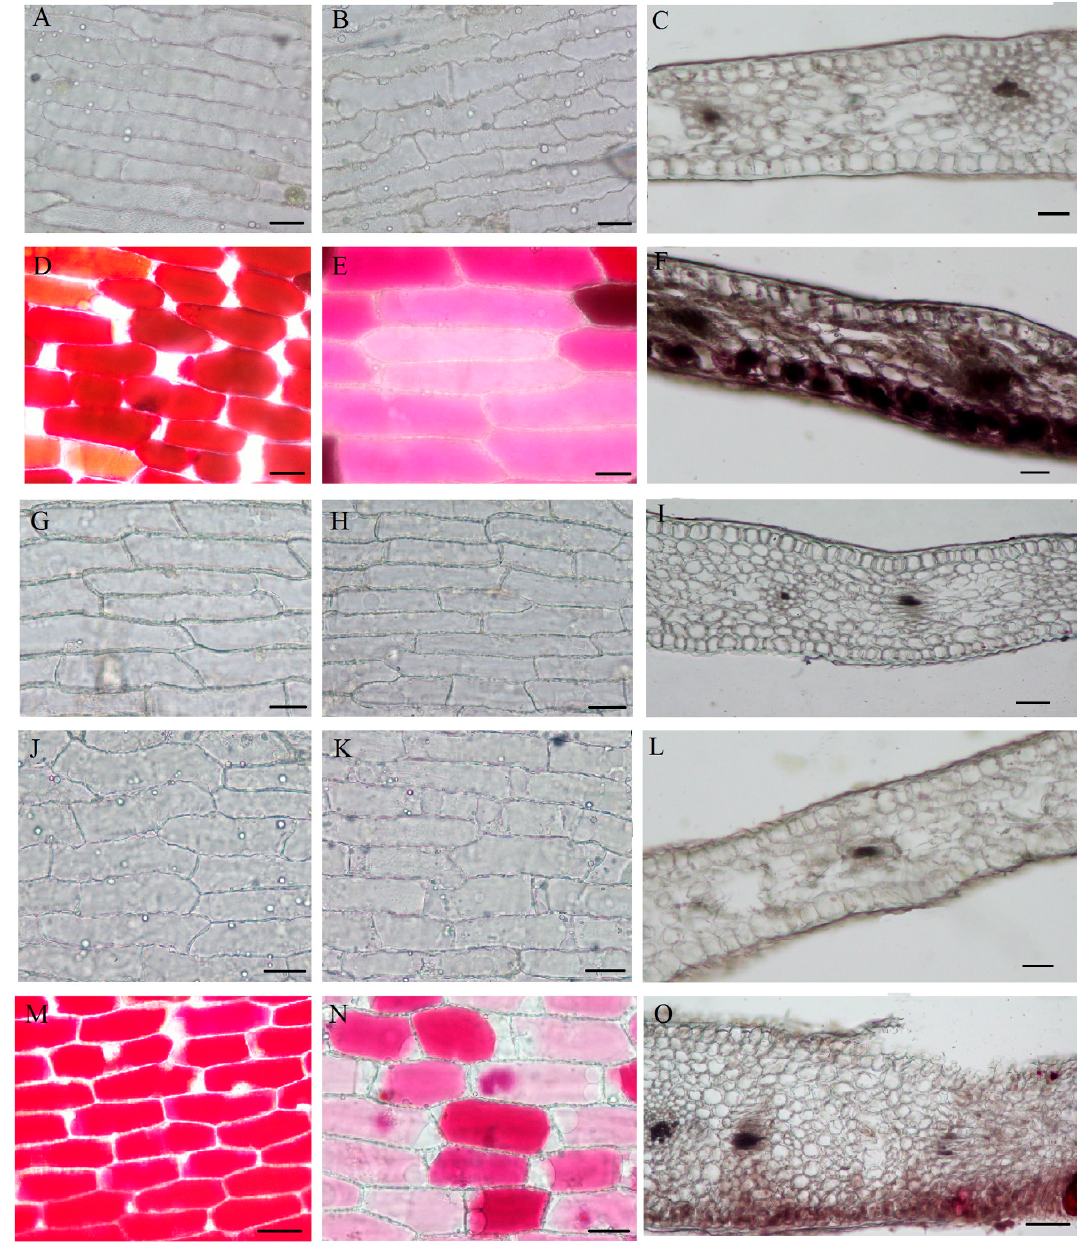
Figure 2. Cellular features of the flower materials. Bar = 100 mm. (( A )–( C ), ( G )–( I ) and ( J )–( L )) the abaxial, adaxial and cross section of the background petals of P. rockii , P. ostii and the F1 progeny, respectively; (( D )–( F ) and ( M )–( O )) the upper epidermis, lower epidermis and cross section of the background petals of P. rockii and the F1 progeny, respectively.